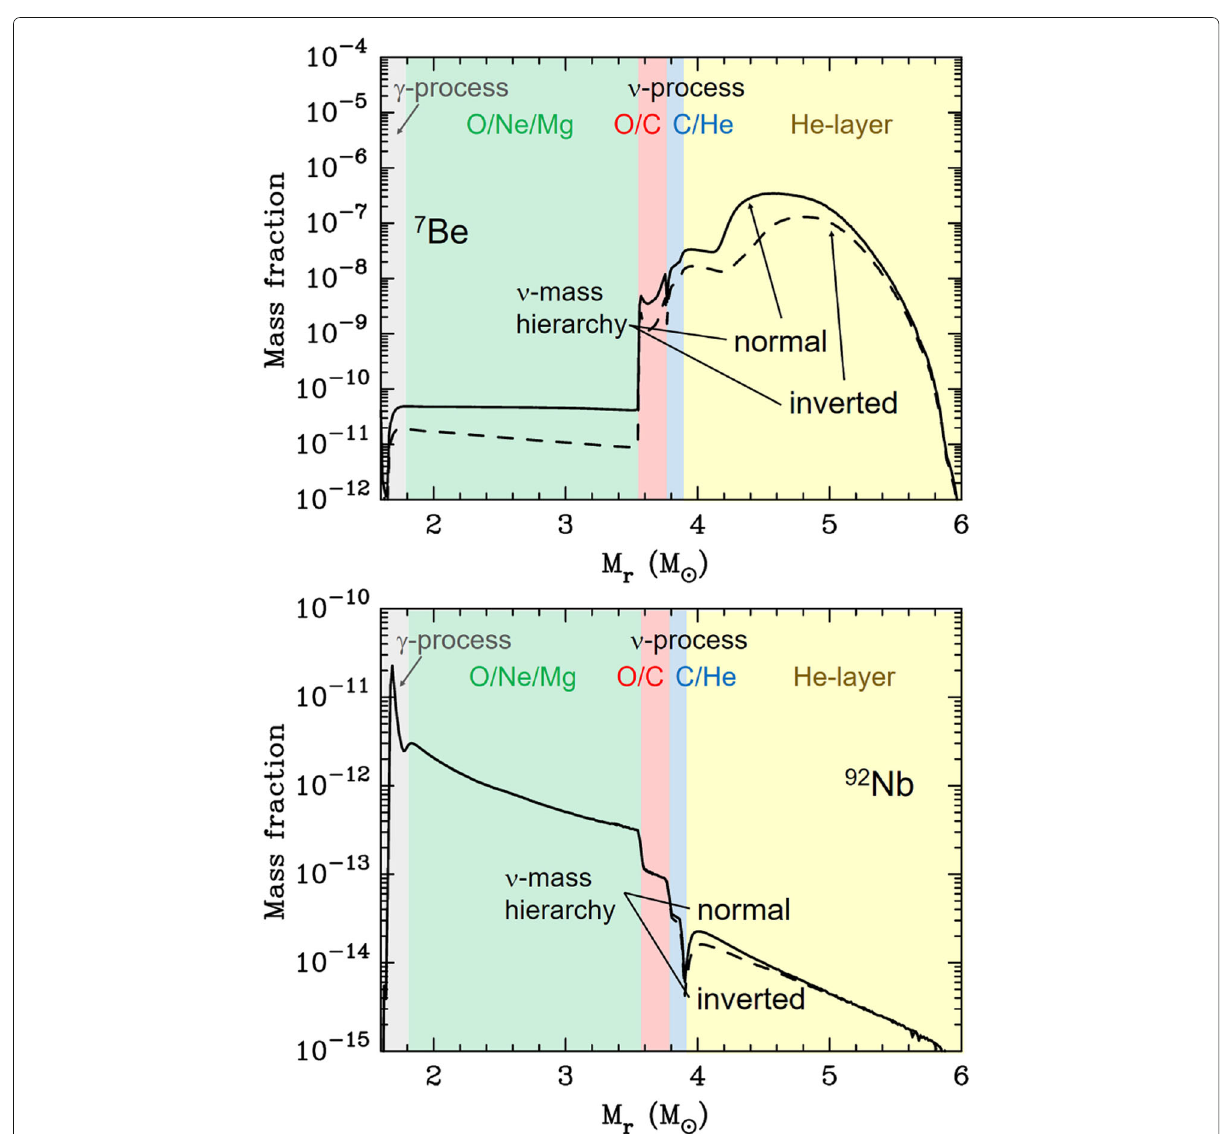
Fig. 7 Mass fractions of 7 Be (upper panel) and 92 Nb (lower) versus M r in SN 1987A model star. Solid and dashed curves are the results for normal and inverted mass hierarchies, respectively [274]. Colors distinguish γ -process region at high temperature, O/Ne/Mg, O/C, C/He, and He-rich layers for ν -process region as labeled. 7 Be is mainly produced in the outer He-layer, while 92 Nb is produced also in the central hot region via the γ -process as well as ν